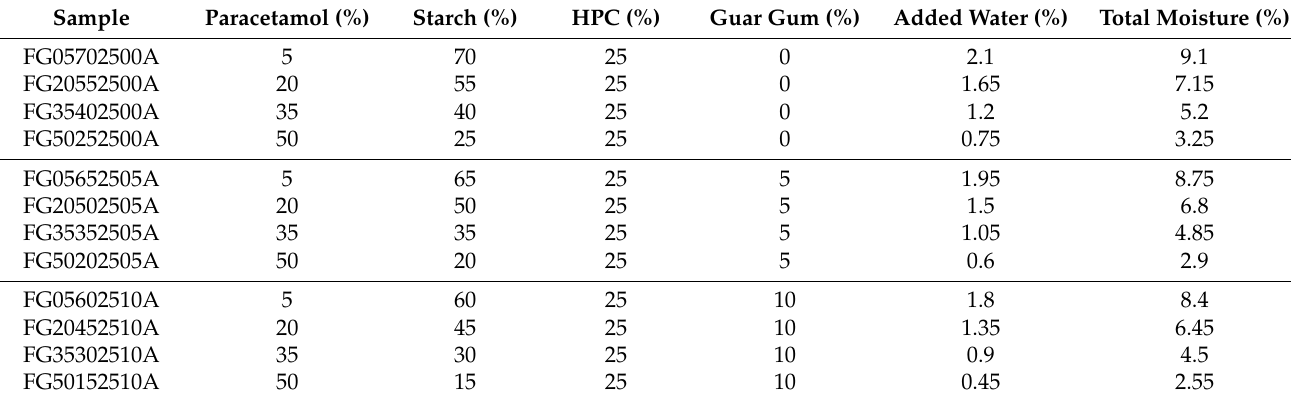
Table 1. Identification and proportions of paracetamol, starch, HPC, Guar gum, added ultrapure water and calculated total moisture of each sample.